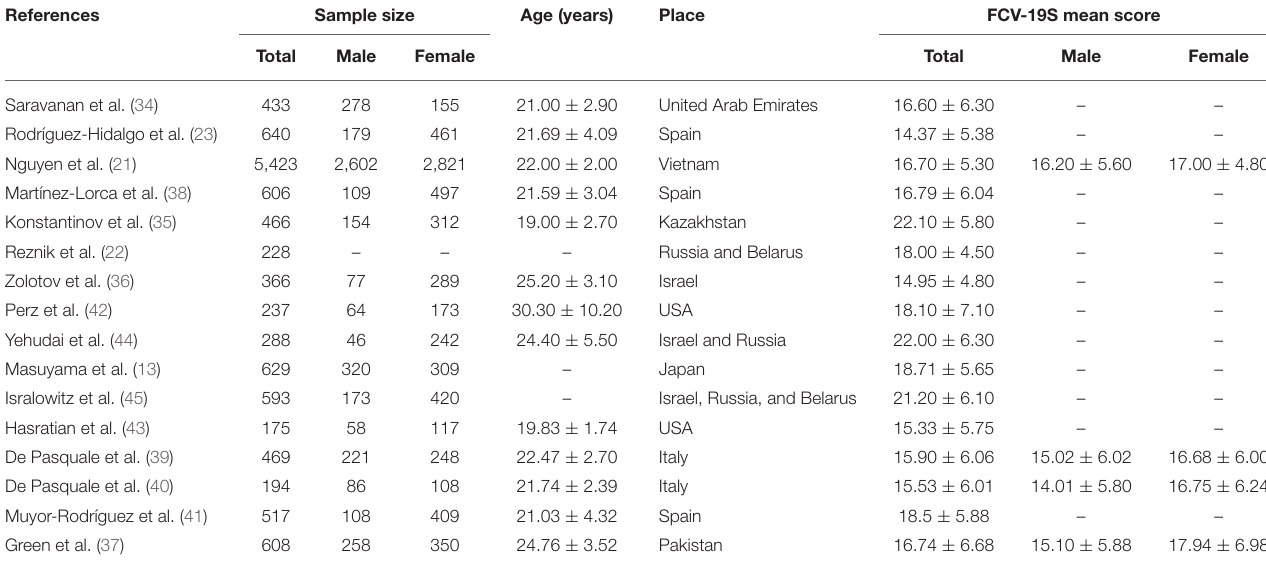
TABLE 1 | Characteristics of studies included in the